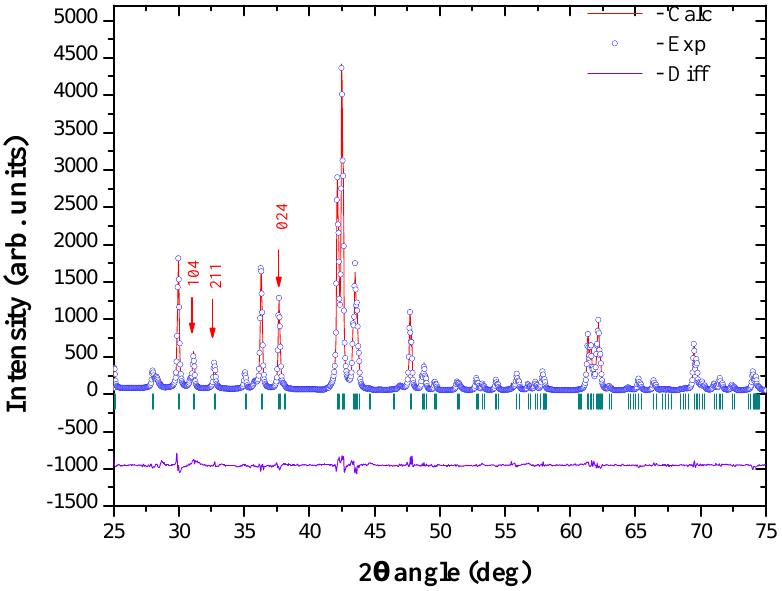
Figure 3. Rietveld refinement of XRD for nanocrystalline Sm 2 Fe 16 Ga